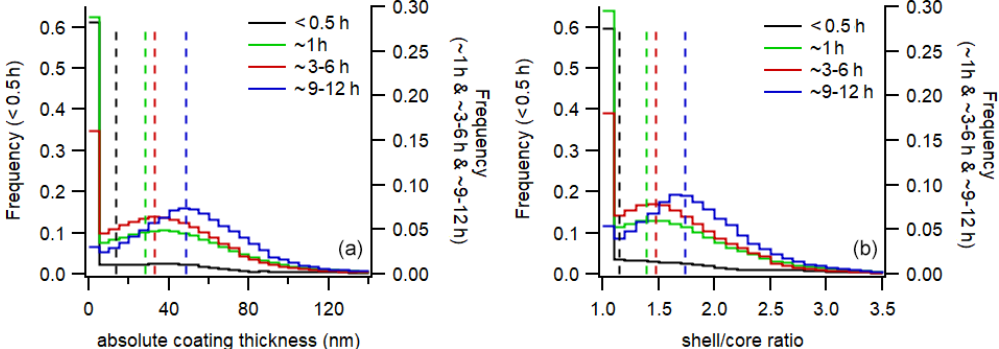
Figure 5. Distributions of measured coating thickness of BC-containing particles in sampled smoke plumes at different ages in terms of shell / core ratios (a) and absolute coating thickness (b) . The first bin ( D P /D C = 1, uncoated particle) contains particles with measured scattering less than that predicted for an uncoated core (equivalent to D P < D C